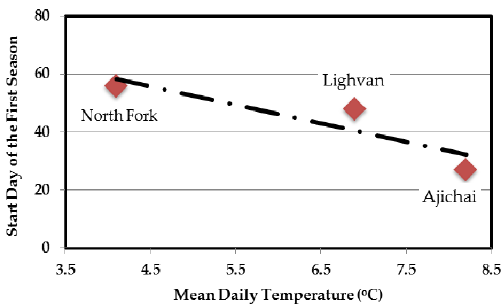
Figure 7. Relation between starting date and the mean daily temperature.